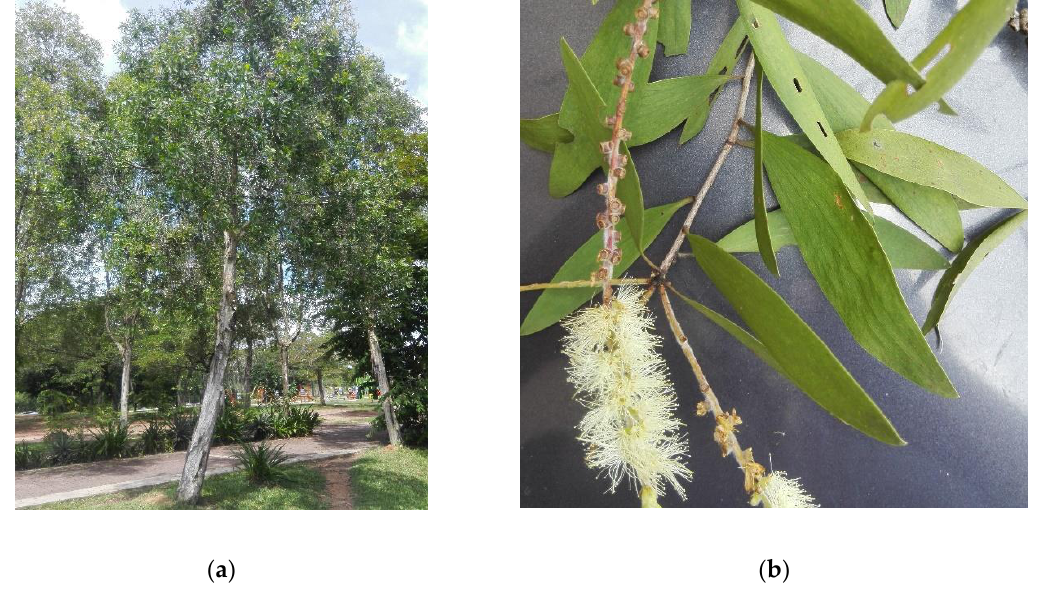
Figure 1. ( a ) Melaleuca cajuputi tree and ( b ) Melaleuca cajuputi leaves.